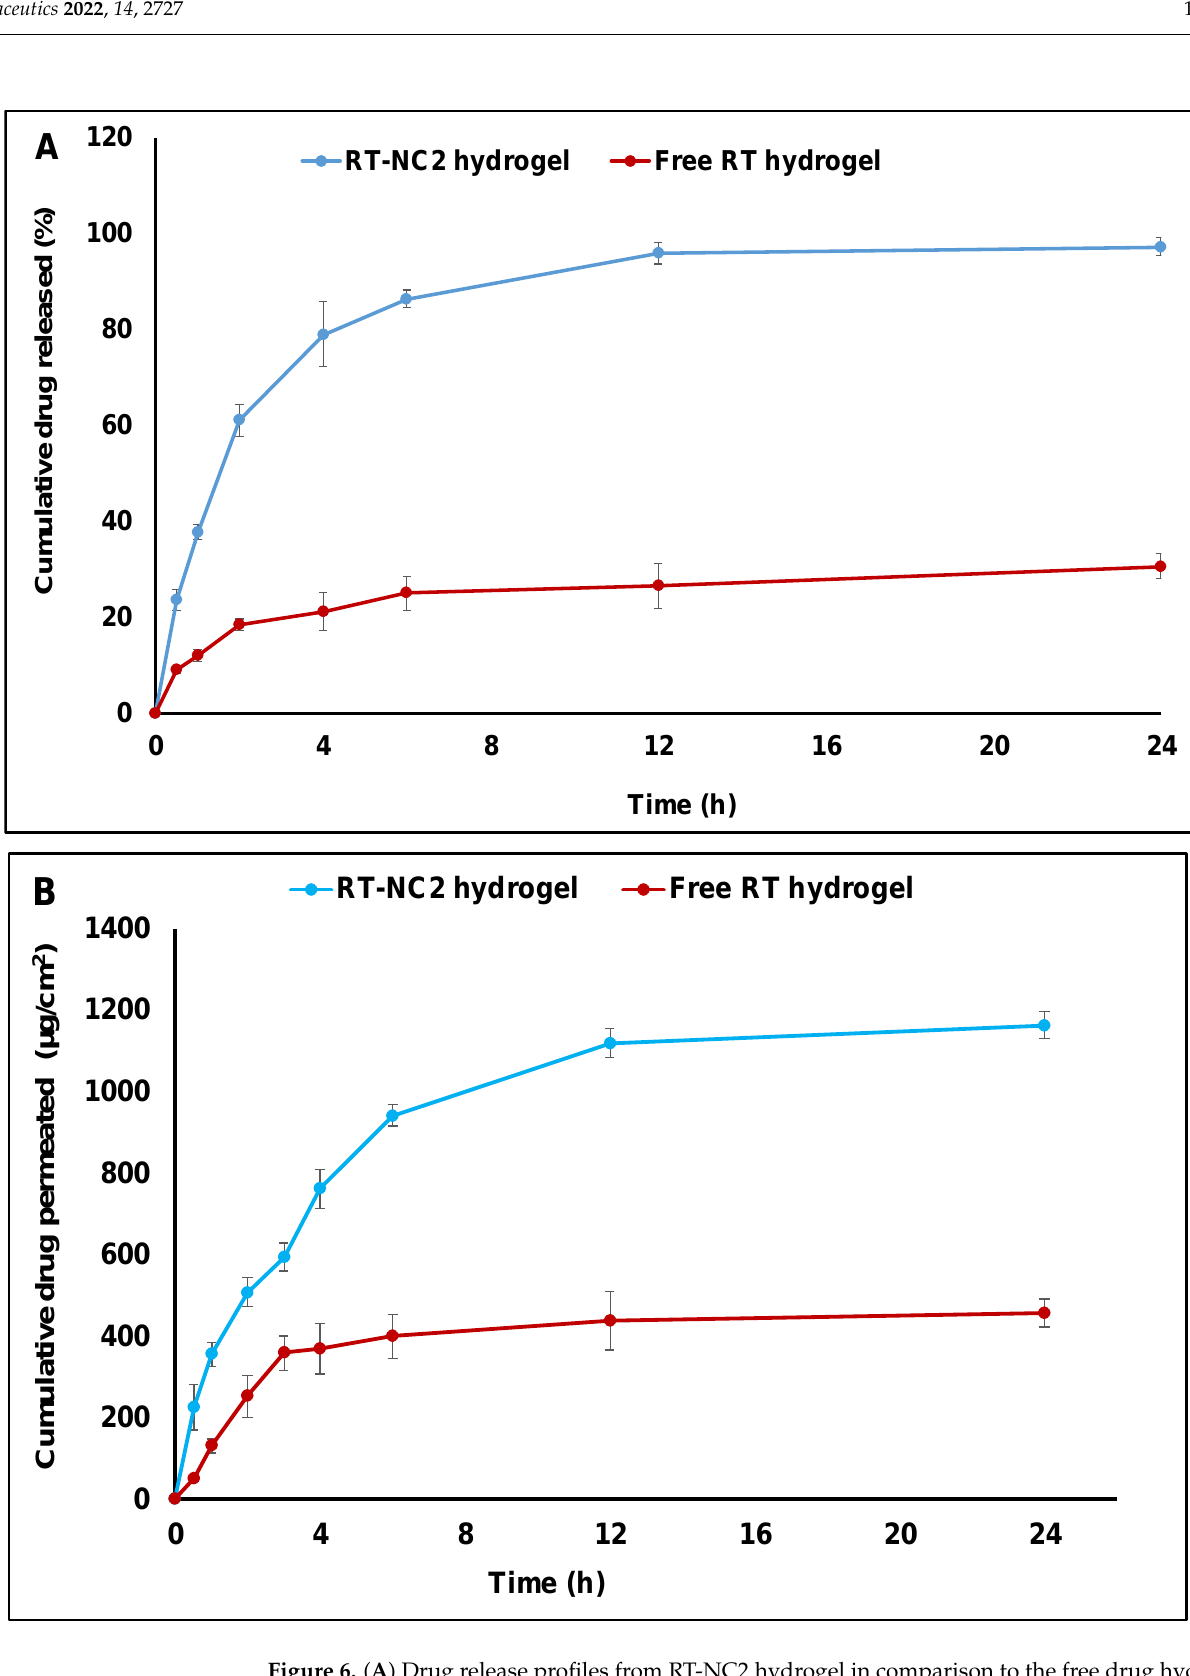
Figure 6. ( A ) Drug release profiles from RT-NC2 hydrogel in comparison to the free drug hydrogel in phosphate buffer pH 6.5 containing 0.25%, v / v ethanol at 37 °C. ( B ) Cumulative amount of RT permeated per unit surface area of mouse abdominal skin (µg/cm 2 ) for free RT hydrogel and RT-NC2 hydrogel.